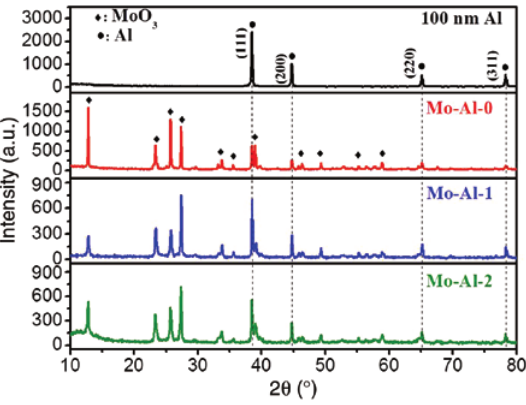
Figure 3: XRD patterns of 100 nm Al-NPs, Mo-Al-0, Mo-Al-1, and